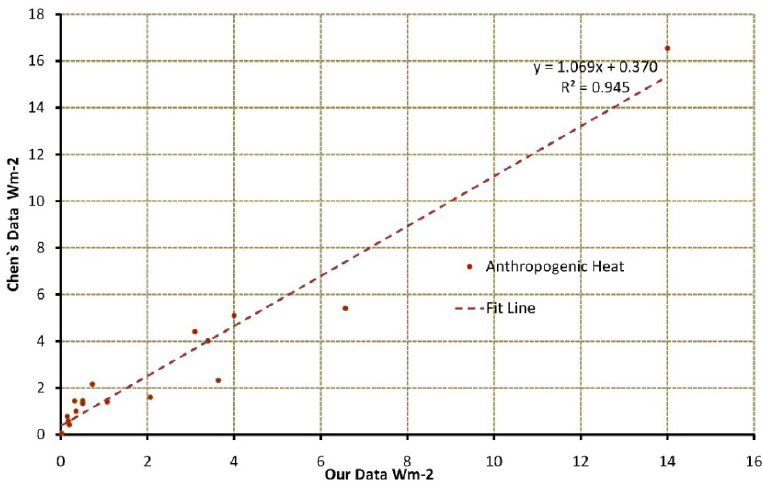
Figure 6. Comparison on AHF between chen’s data and data based on DMSP-OLS.